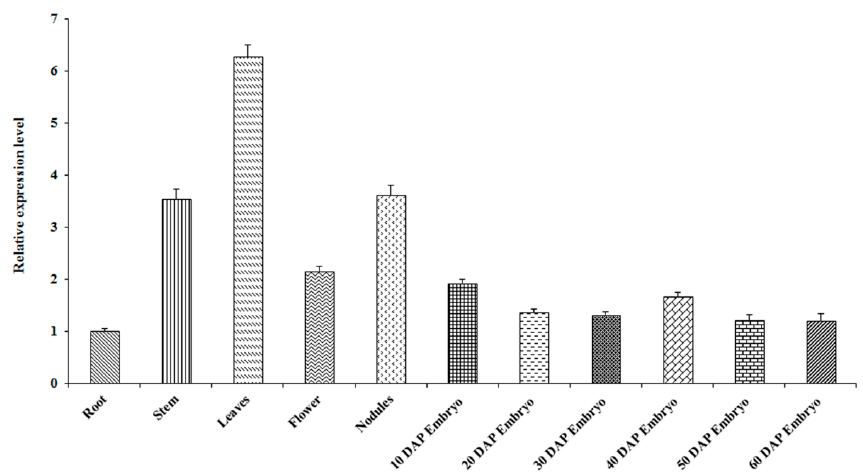
Figure 6. Expression analysis of GmMYB138a in different soybean tissues and developmental seeds. Total RNA extracted from soybean root, stem, leaf, nodule, flower, embryo (10, 20, 30, 40, 50 and 60 days after pollination) were used for qPCR analysis. Three biological replicates and three technical replicates for each biological replicate were carried out. The standard error of the mean is represented by an error bar. The data were normalized against SUBI-3 .